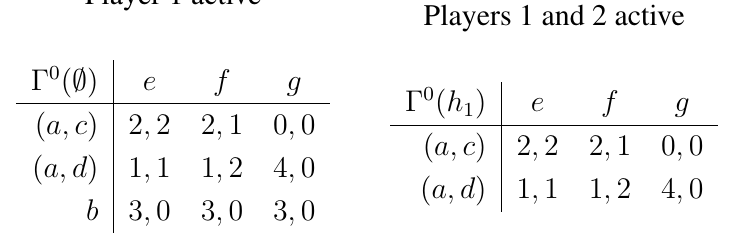
Table 1. The full decision problems in Figure